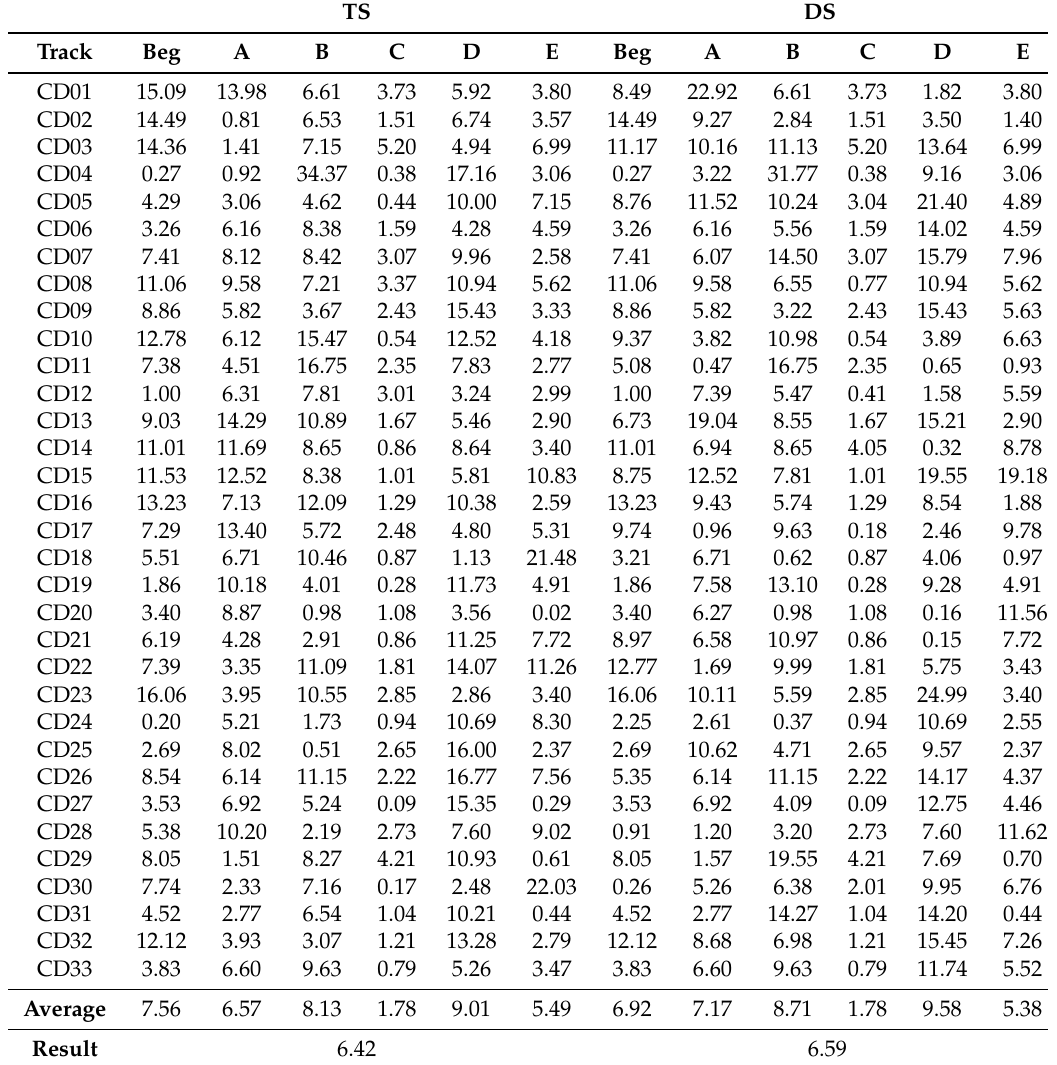
Table A3. Differences between the estimated GT and the EAT for both systems. TS